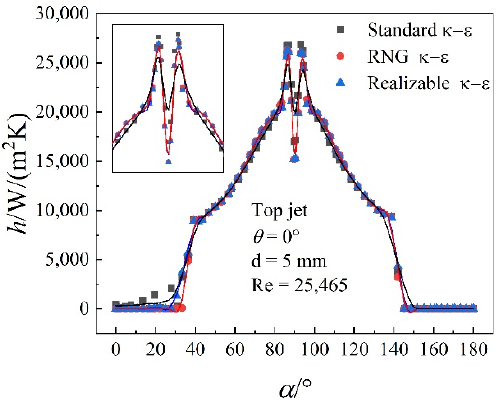
Figure 4. Distribution of the local heat transfer coefficient ( h ) in circumferential direction angle ( α ) of steel tubes with different turbulence models.